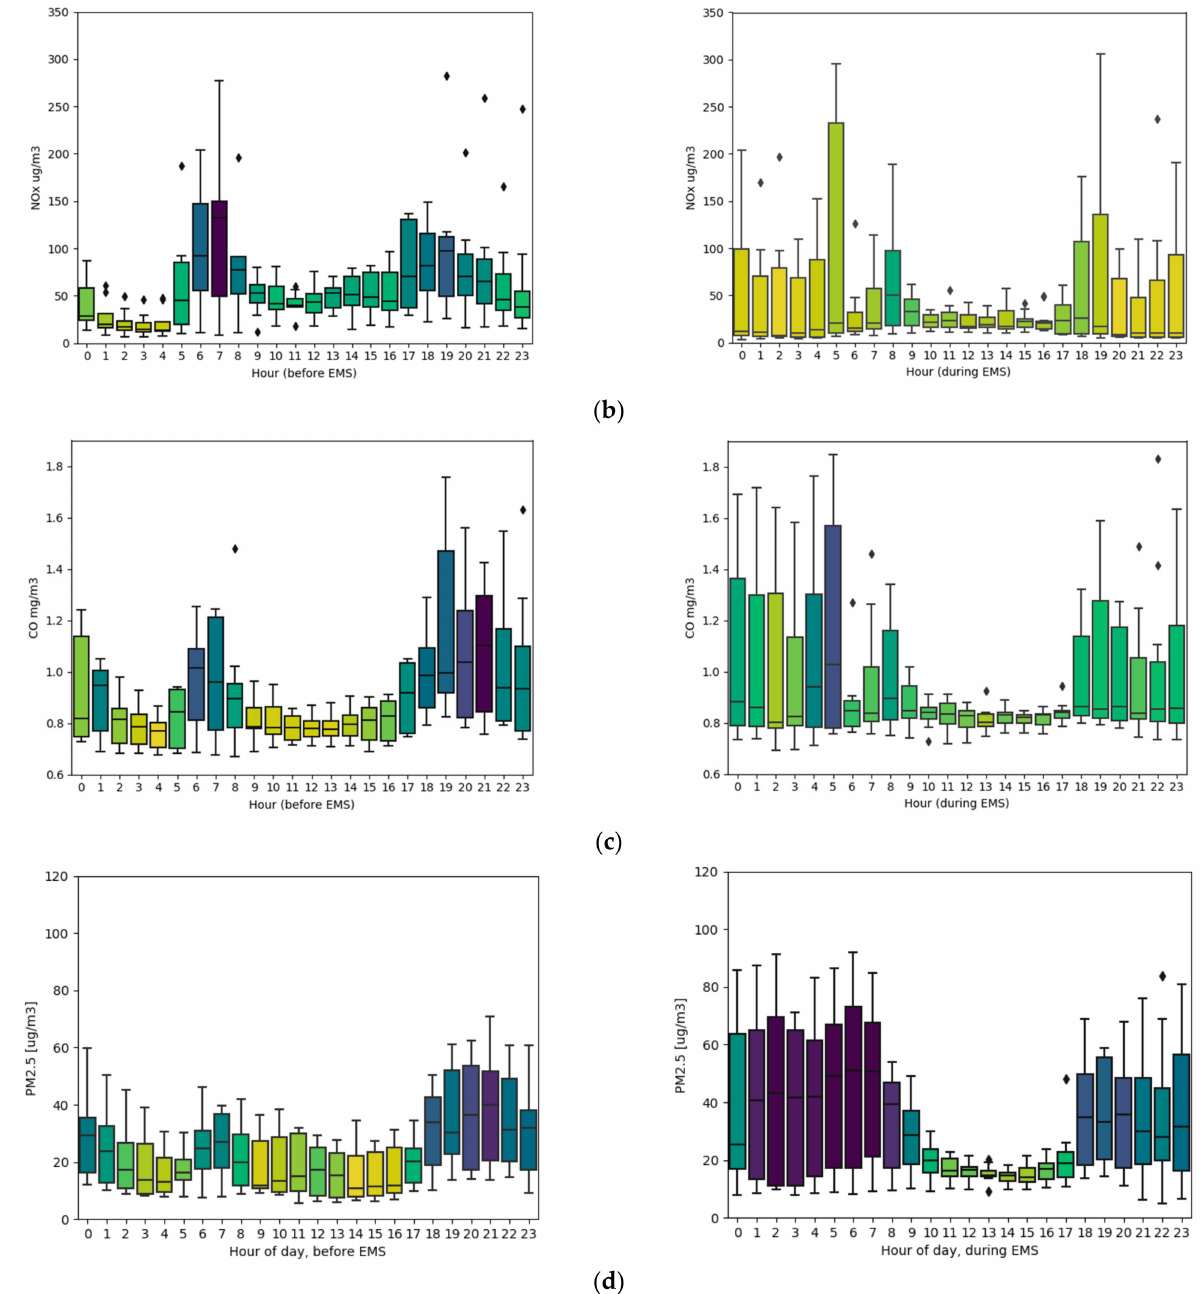
Figure 6. Rumenaˇcka SEPA, NN1 station, hourly boxplots before ( left ) and during emergency state ( right ) ( a ) SO 2 ( b ) NO x ( c ) CO ( d ) PM 2.5